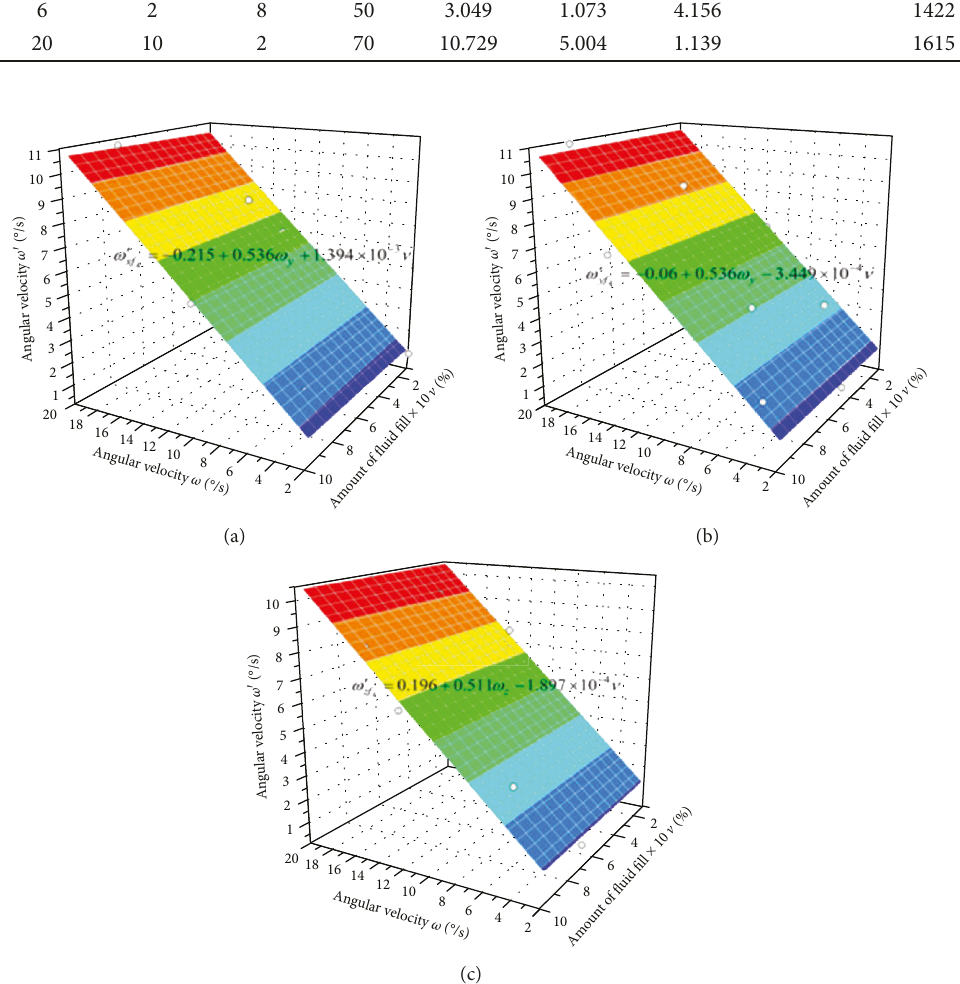
′ , (b) ω ′ , (c) ω ′ . xf 4 yf 4 zf 4